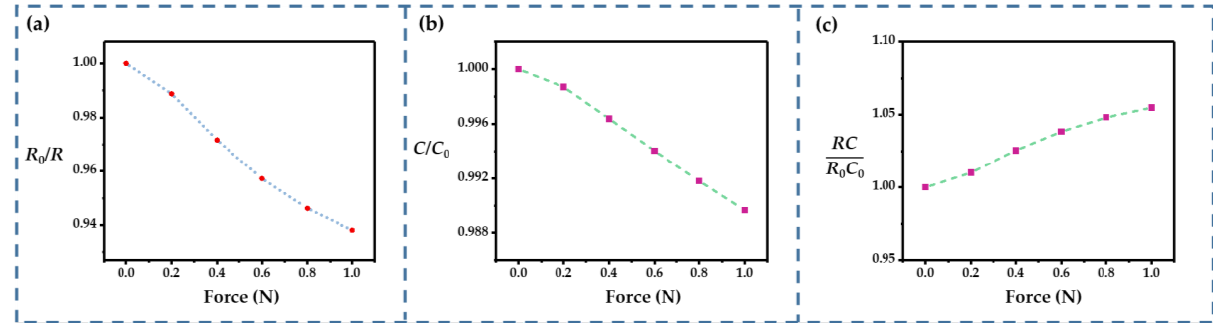
Figure 6. Simulation results: ( a ) R 0 / R vs. external forces; ( b ) C / C 0 vs. external forces; ( c ) RC / R 0 C 0 vs. external forces.